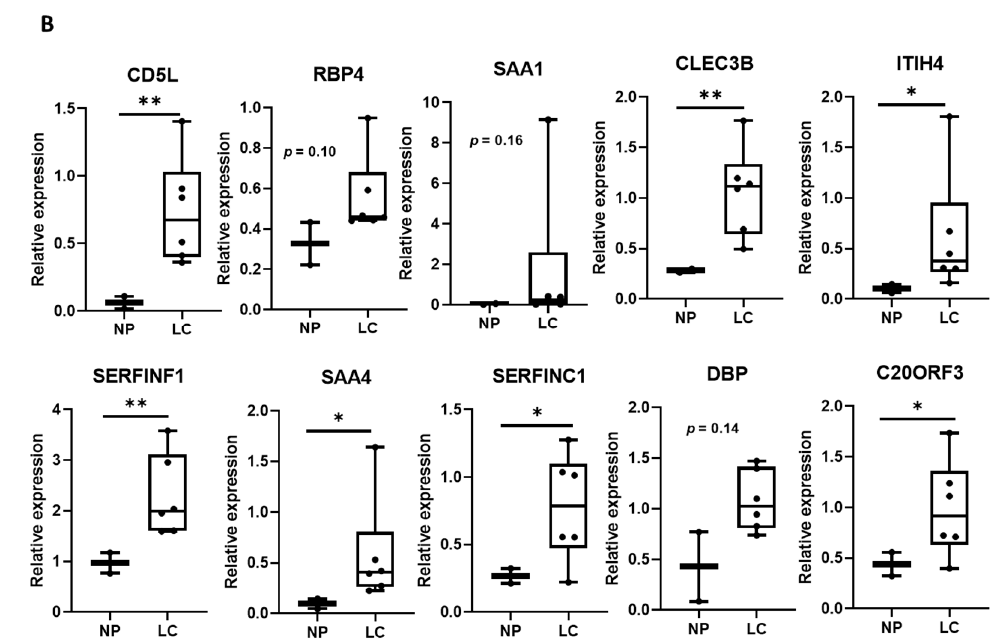
Figure 2. Validation of proteins expressed in EVs derived from patient and normal serum samples. ( A ) Identification of biomarker candidates expressed in serum-derived EVs using Western blotting. SCC, squamous cell carcinoma; AC, adenocarcinoma lung cancer. ( B ) Quantification of protein bands in Western blotting by image analysis. ** p < 0.01; * p < 0.05. NP, normal person; LC, lung cancer patient.